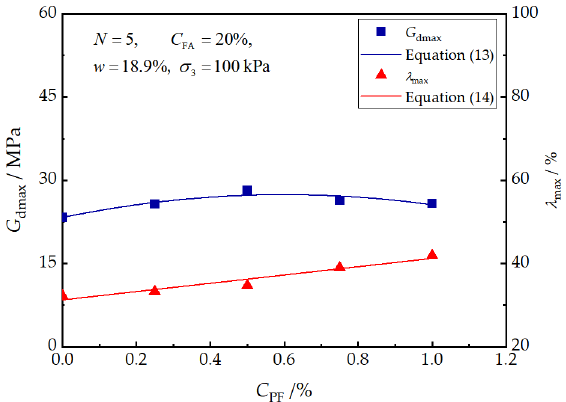
G and λ . Figure 12. Effects of polypropylene fiber content on G max dmax and λ max . dmax